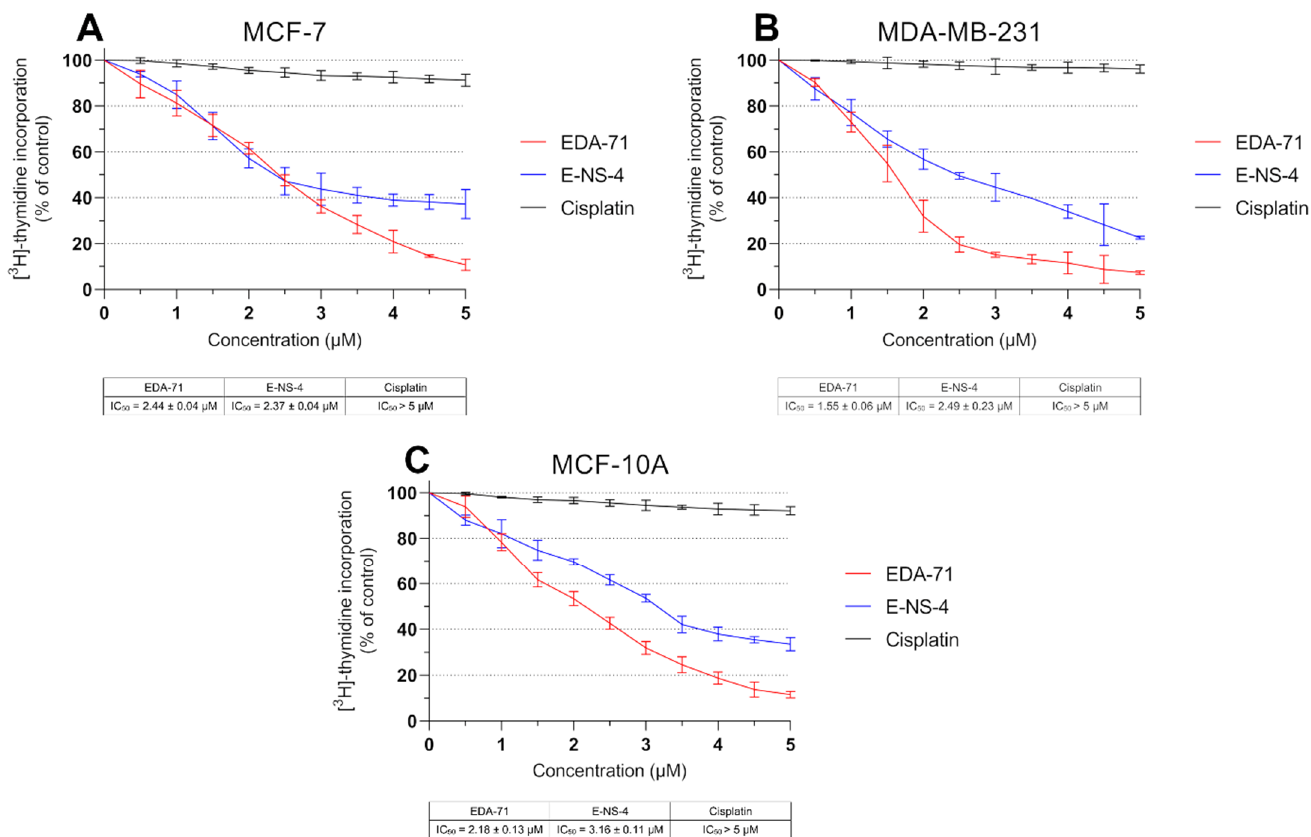
Figure 3. DNA biosynthesis process (incorporation of [ 3 H]-thymidine into DNA) observed in MCF-7 ( A ) and MDA-MB-231 ( B ) breast cancer cells and MCF-10A normal breast epithelial cells ( C ) incubated for 24 h with the tested compounds and cisplatin at various concentrations. Results are presented as mean values (percent of untreated cells) ± SD obtained from three independent experiments ( n = 3) conducted in triplicate.